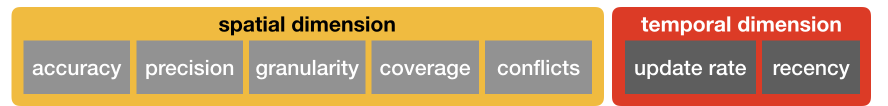
Figure 2. Aspects representing quality of location and orientation information along the spatial and temporal